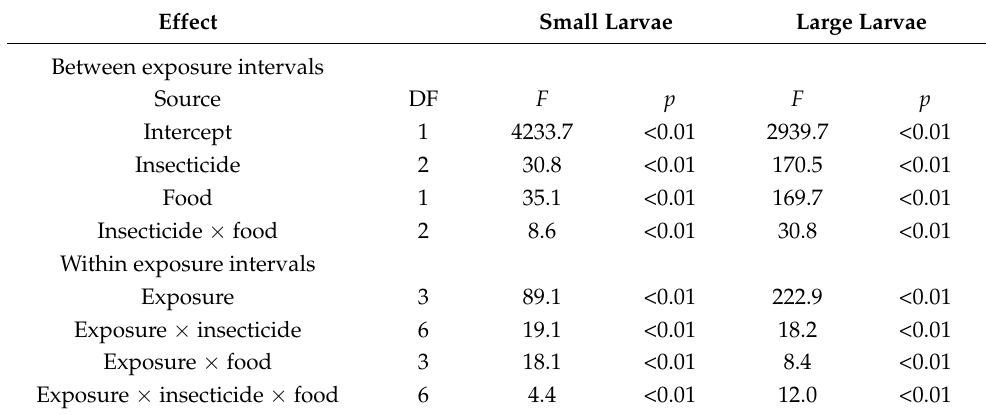
Table 1. MANOVA parameters for main effects and associated interactions for mortality of Alphitobius diaperinus small and large larvae between and within exposure intervals (error DF = 48).